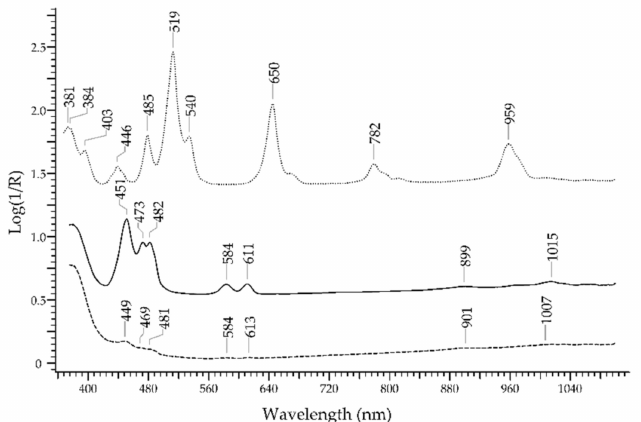
Figure 20. FORS spectrum in Log(1/R) coordinates of a green (solid line), a pink (dotted line) and a yellow (dashed line)